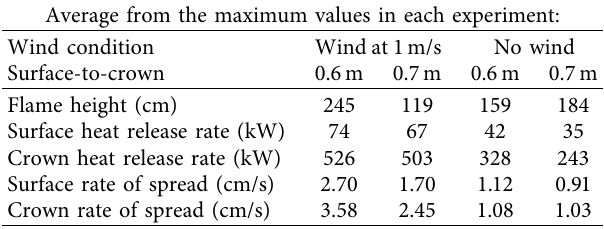
Table 2: Summary of results for the maximum values for each experimental category. Average from the maximum values in each experiment: Wind